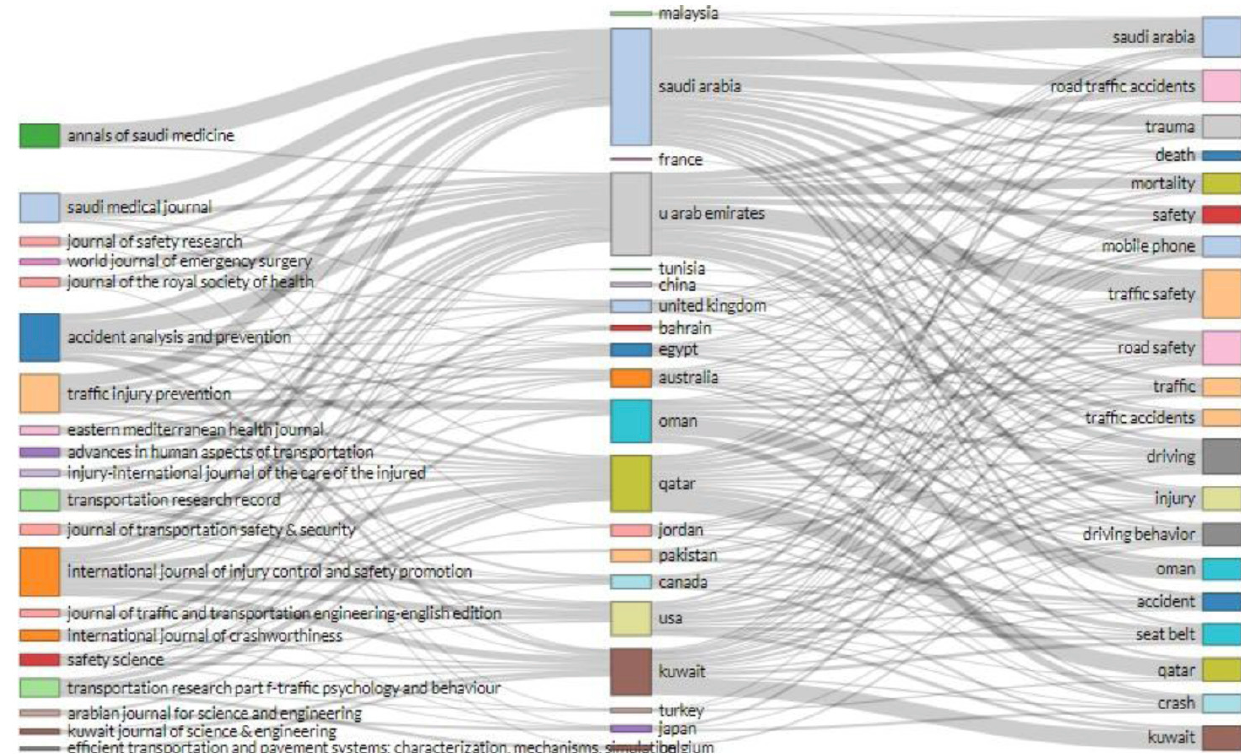
Figure 9. Three-factor analysis of road traffic injuries research in the Gulf Cooperation Council region using nation (center), journal (left), and keyword (right) parameters. (generated using Biblioshiny Software R